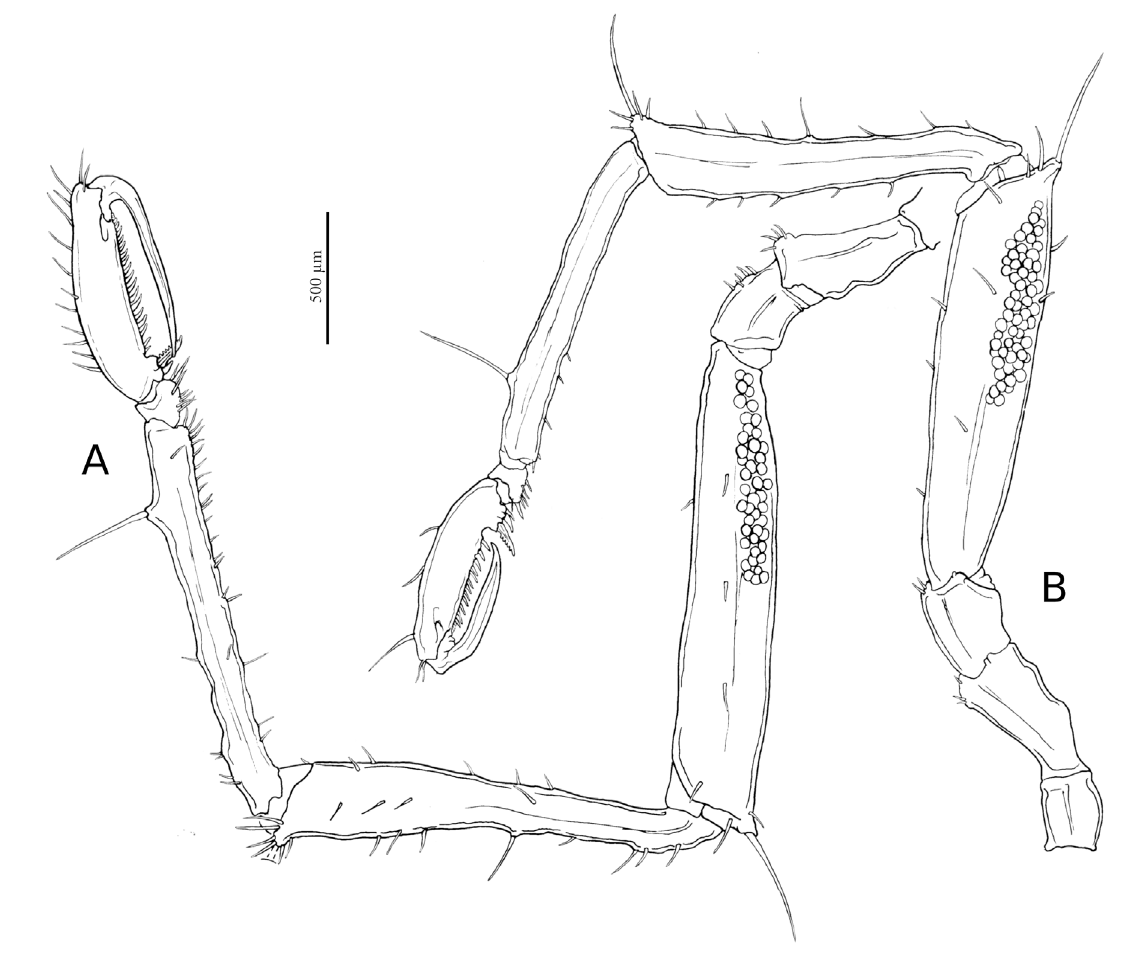
Fig. 23. Anoplodactylus madibenthos sp. nov., paratype, ♀, MNHN-IU-2016-1202. A . First leg. B . Third